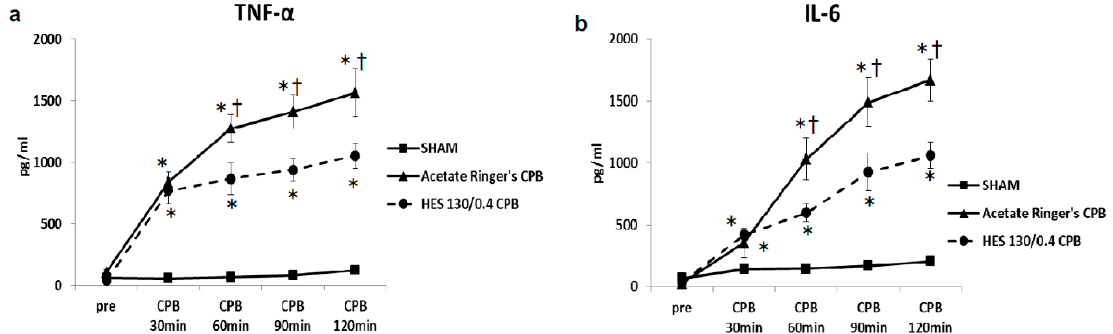
Figure 6. Plasma TNF- α ( a ) and IL-6 ( b ) [35]. * p < 0.05 versus the SHAM group, † p < 0.05 versus the HES 130/0.4 CPB group at the same point in time.